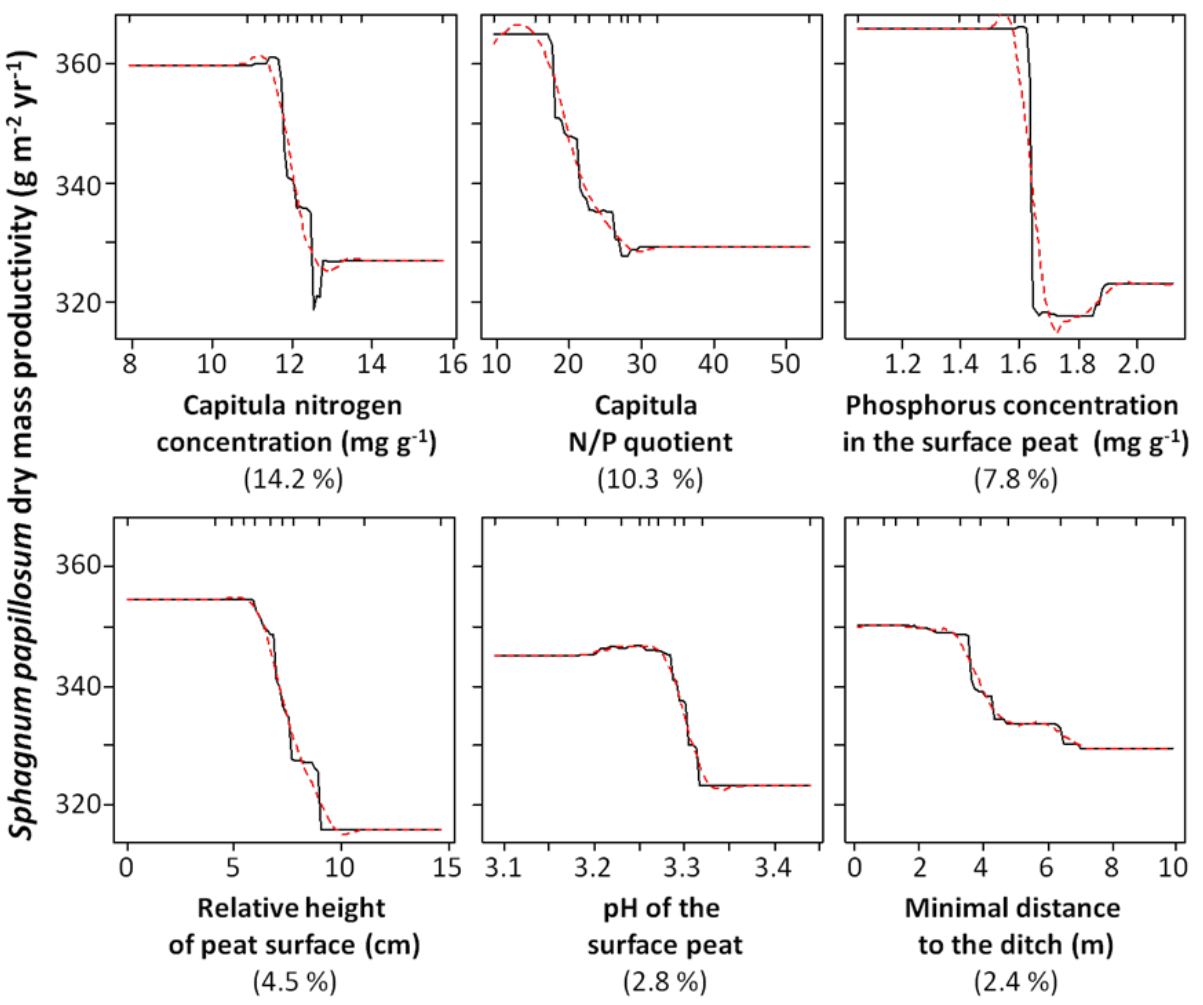
Figure 12. Boosted regression tree model of Sphagnum papillosum biomass productivity in g m -2 yr -1 (response variable) between 2008 and 2010 and its predictor/explanatory variables dry mass nitrogen concentration (mg g -1 ) in capitula, capitula N/P quotient, dry mass phosphorus concentration (mg g -1 ) of the surface peat, relative height of the peat surface (cm above lowest peat surface altitude), pH of the surface peat, and minimal distance to the ditch (m). Percentages in the abscissa labels (in brackets) give the absolute contributions of individual variables to biomass productivity. The red (dashed) line is the smoothed relationship between the Sphagnum papillosum biomass productivity and the individual explanatory variable. The vertical markers on the ‘box’ line at the top indicate real observations. The boosted regression tree model was performed with 61 observations and six predictors, using the Poisson distribution, with tree complexity = 2, learning rate = 0.001, and bag fraction = 0.75. The final model was fitted with 2850 trees and explained deviance = 0.42. No relationship was observed for minimal distance to the irrigation pipes (m), dry bulk density (g L -1 ), dry mass nitrogen concentration (mg g -1 ), C/N quotient and degree of humification of the surface peat, dry mass phosphorus and potassium concentrations (mg g -1 ) and N/K quotient of the peatmoss capitula, cover of litter and vascular plants (both